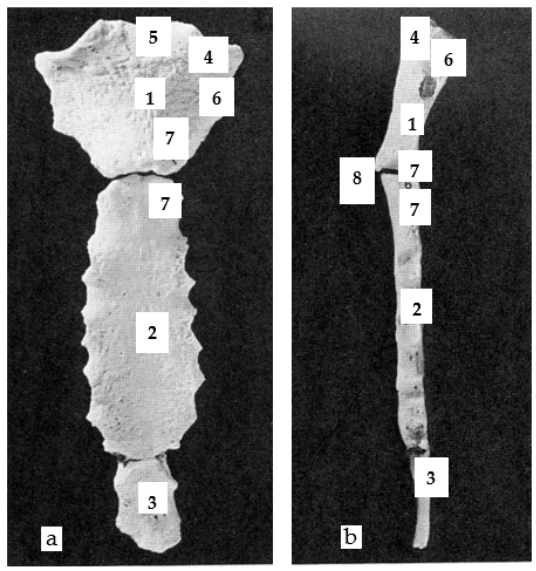
Figure 3. The anterior view ( a ), and the left lateral view ( b ) of the sternum.